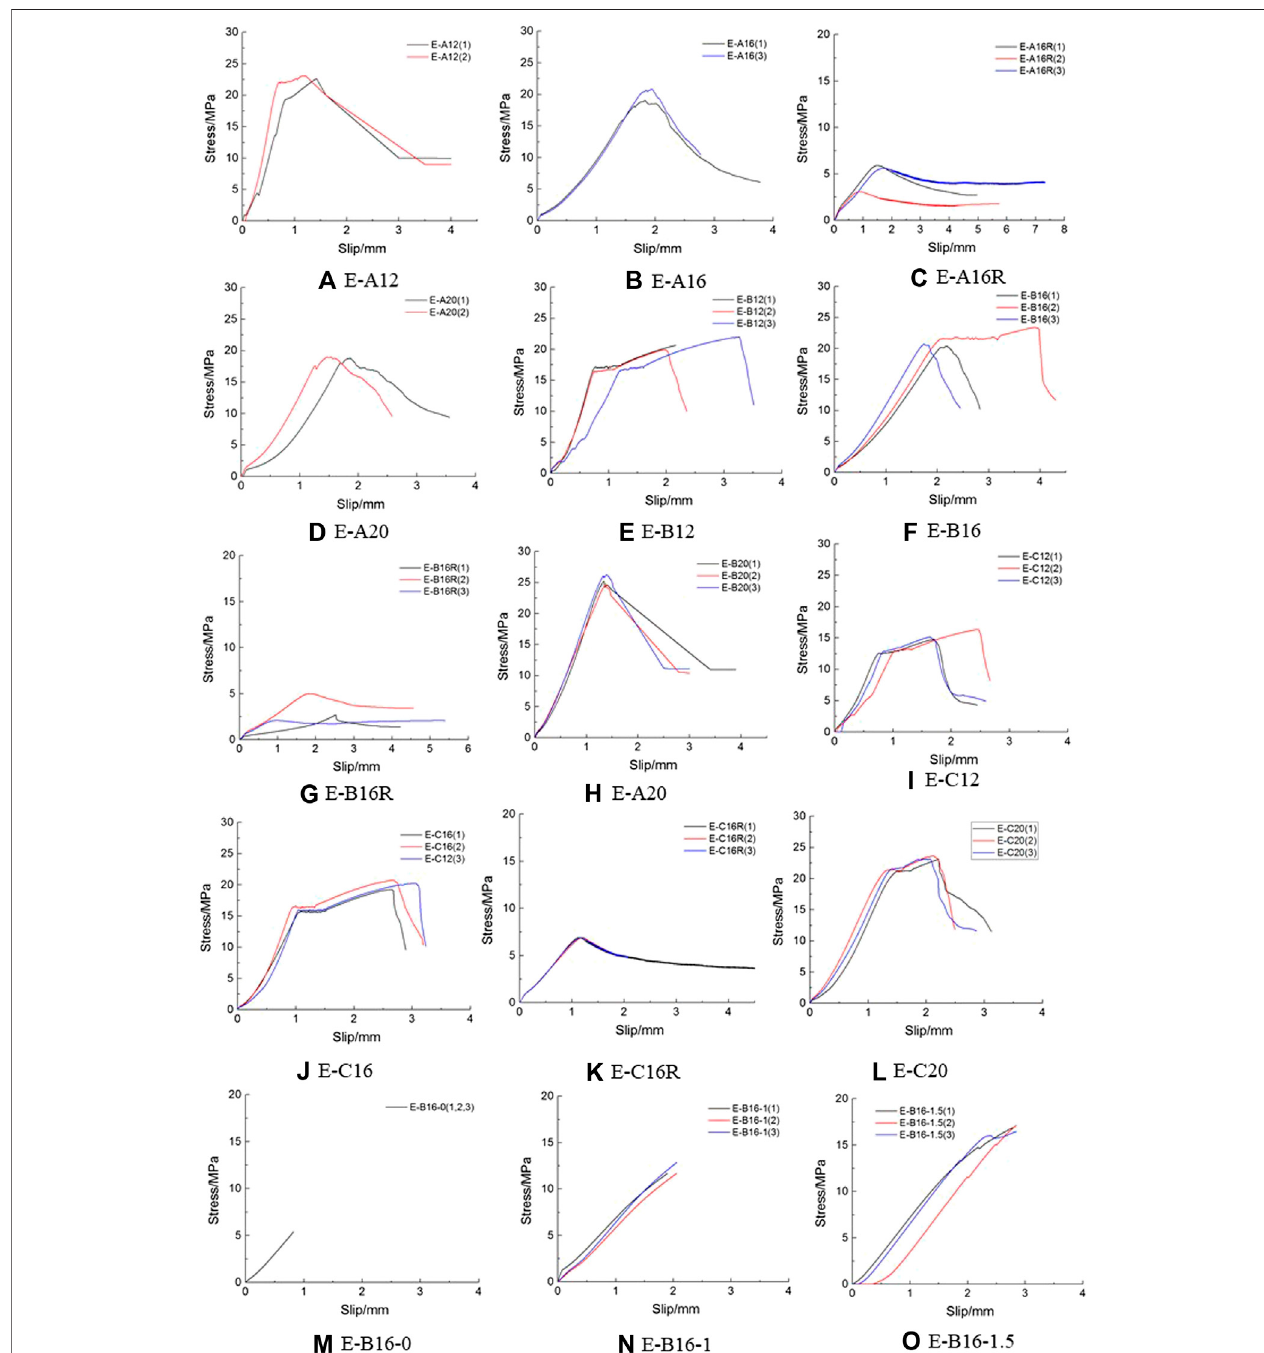
FIGURE 6 | Bond stress-slip